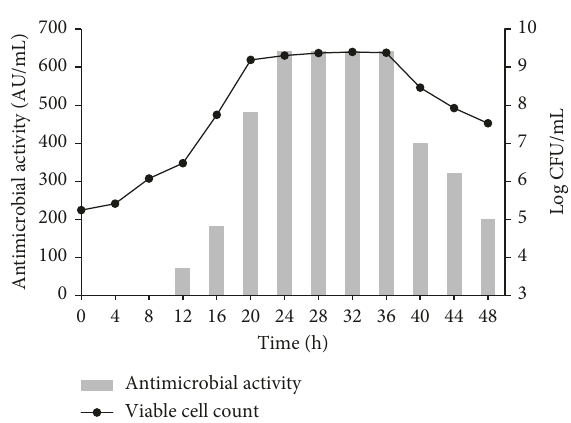
Figure 1: Production of bacteriocin by B. animalis BB04 in 5L fermentor with controlled pH at 37 °